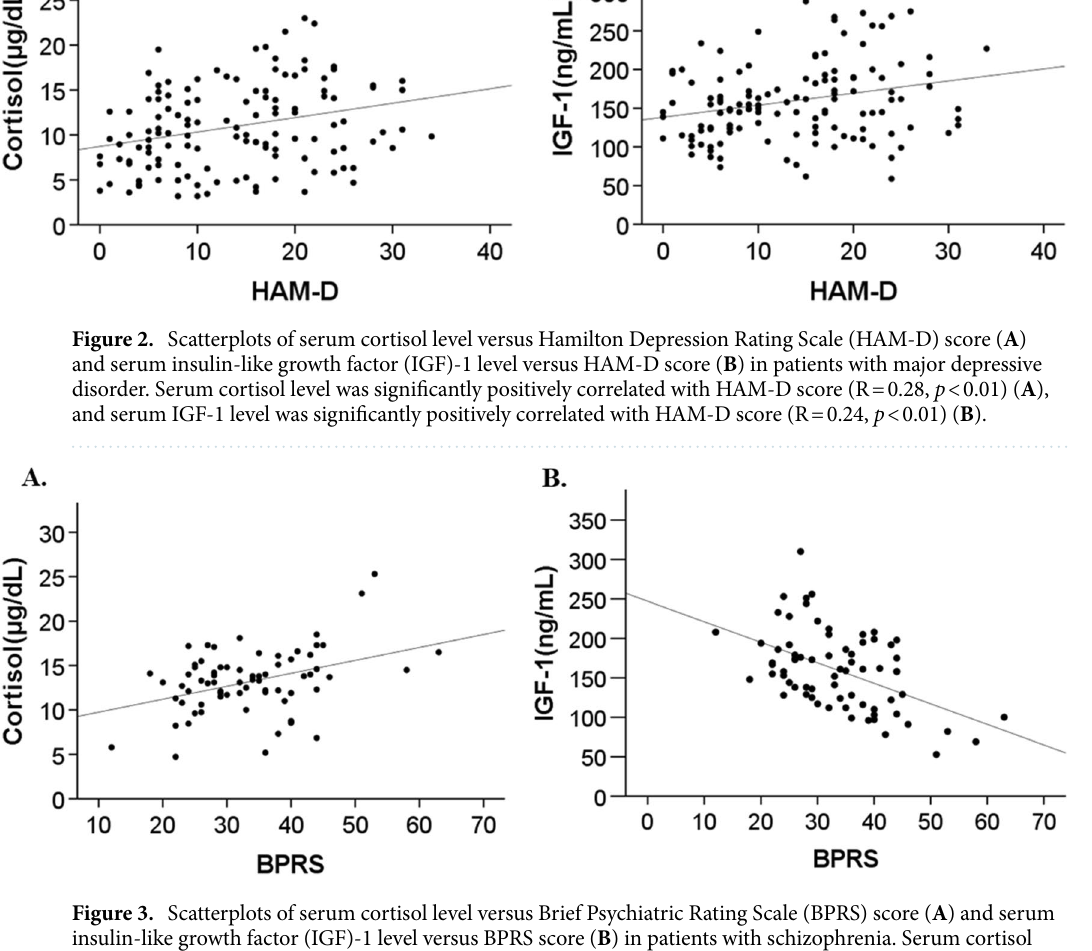
Figure 3. Scatterplots of serum cortisol level versus Brief Psychiatric Rating Scale (BPRS) score ( A ) and serum insulin-like growth factor (IGF)-1 level versus BPRS score ( B ) in patients with schizophrenia. Serum cortisol level was significantly positively correlated with BPRS score (R = 0.38, p < 0.01) ( A ), and serum IGF-1 level was significantly negatively correlated with BPRS score (R = − 0.50, p < 0.01) ( B ).